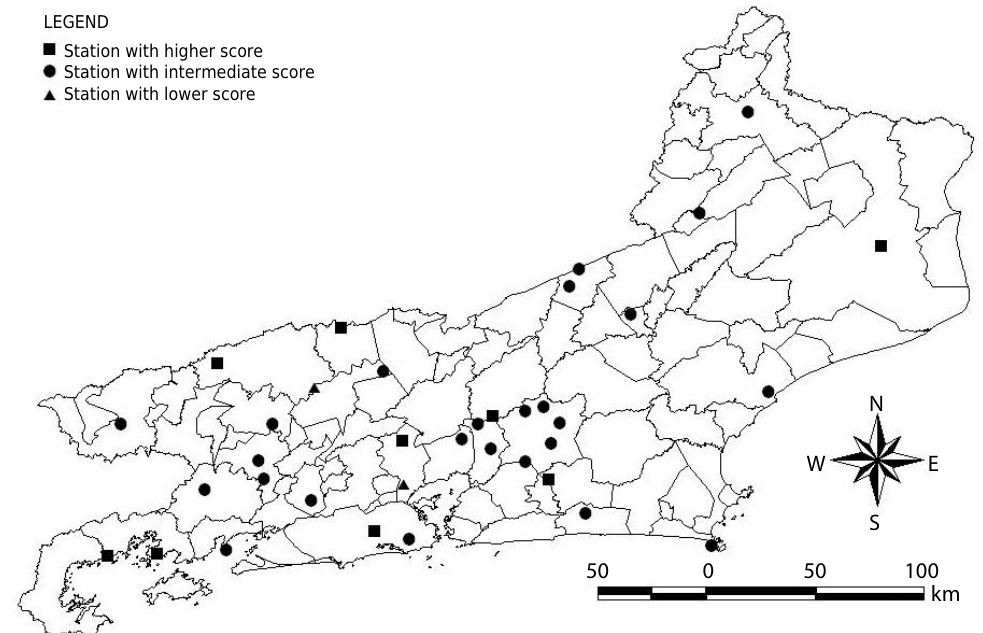
Figure 5. Location of the stations of delayed pattern with respect to the variation in standardized canonical scores of the first canonical discriminant function (CDF 1